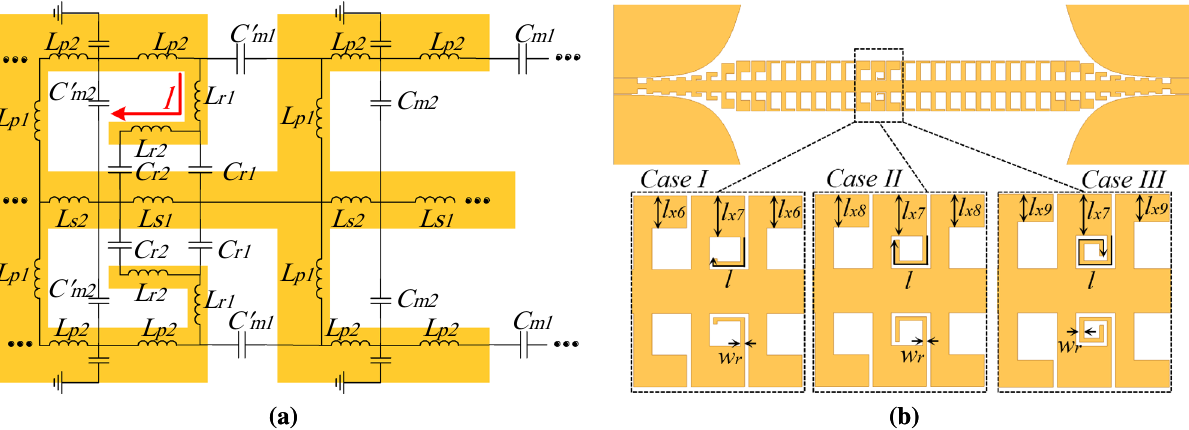
Figure 5. Connection of stub resonators to the SSPP line. ( a ) The unit cell with connected stub resonator and its circuit model. ( b ) A SSPPs TL with a unit cell loaded by stub resonators in three cases, l = 0.73 in case I, l = 0.83 in case II, l = 1 in case III. CST microwave studio 2020 (https:// www. 3ds. com/ produ cts- servi ces/ simul ia/ produ cts/ cst- studio- suite/) was used to generate this figure.